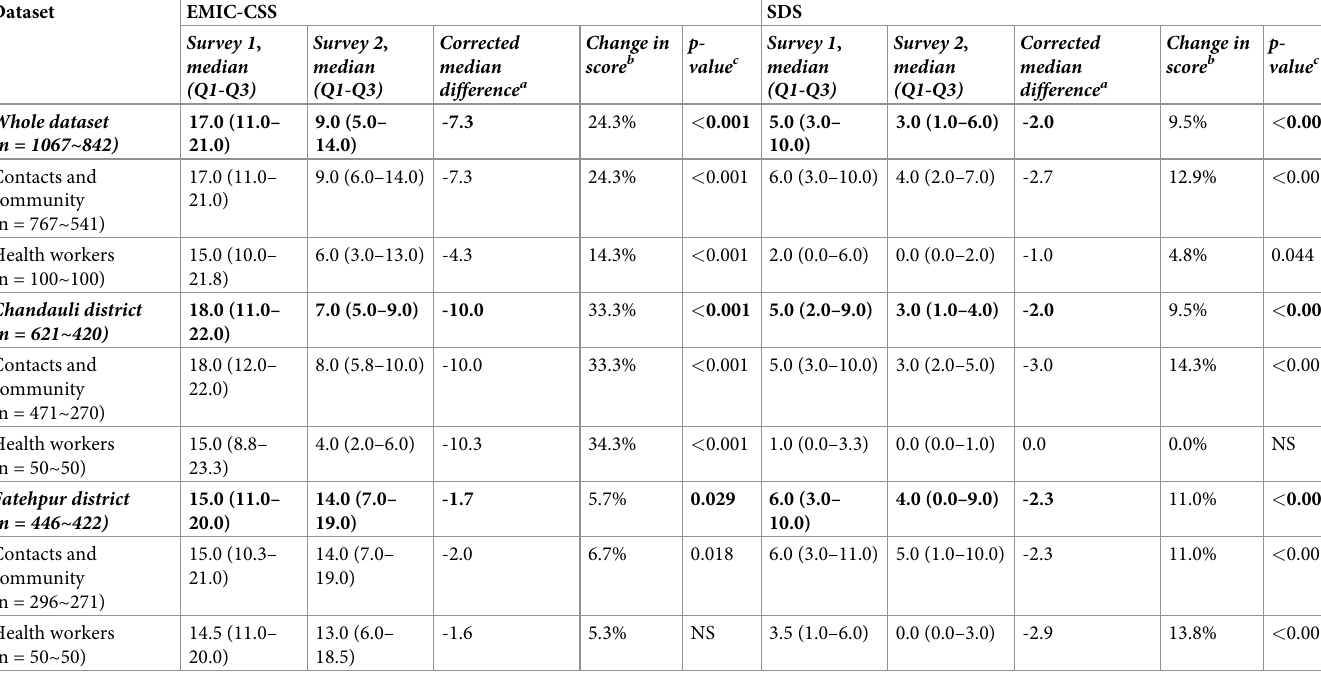
Table 4. Corrected median differences in EMIC-CSS (range 0–30) and SDS (range 0–21) scores between Survey 1 (n = 867) and Survey 2 (n = 641).